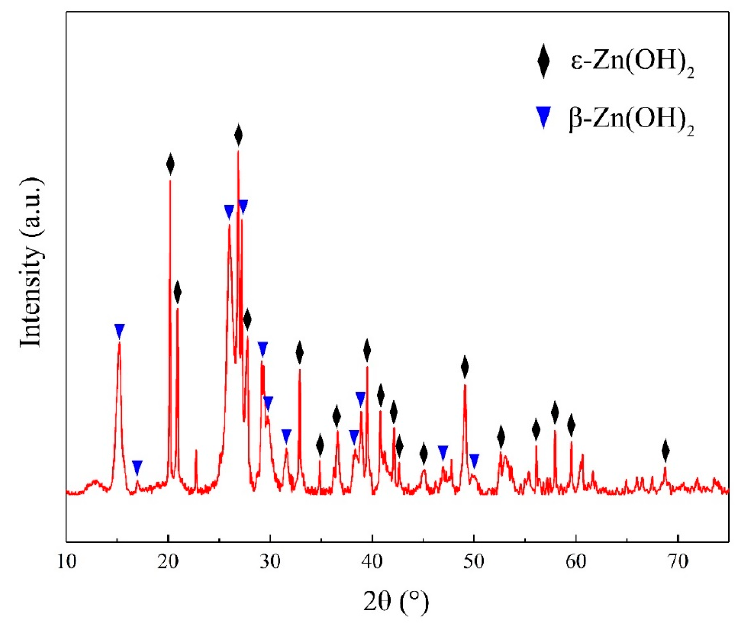
Figure 4. Variation of soluble zinc concentration with reaction time.